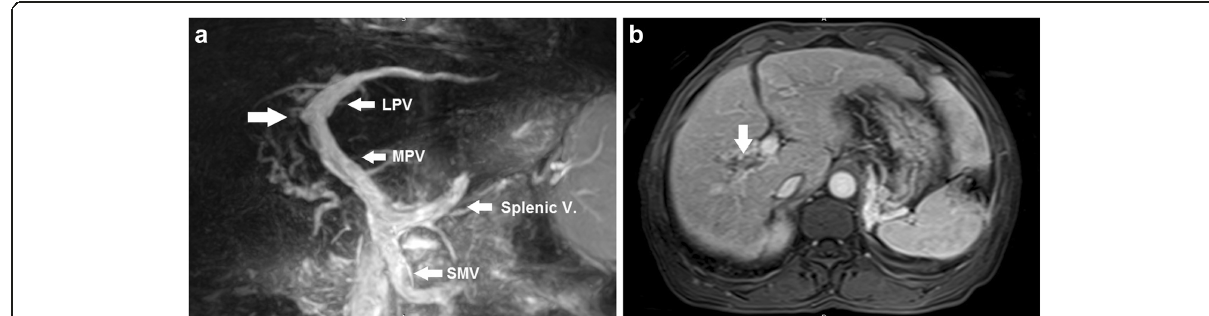
Fig. 4 Right portal vein occlusion. a Coronal MIP image from a non-contrast MR portography using T-SLIP sequence showing total occlusion of right portal branch (arrow) with eccentric filling defect seen at the distal end of the main portal vein representing partial thrombosis. b Axial 3D gradient-echo fat-suppressed T1-weighted contrast-enhanced MR image during portal phase showing hypointense filling defect at the right portal branch (arrow) confirming right portal branch occlusion. MPV, main portal vein; LPV, left portal vein; SMV, superior mesenteric